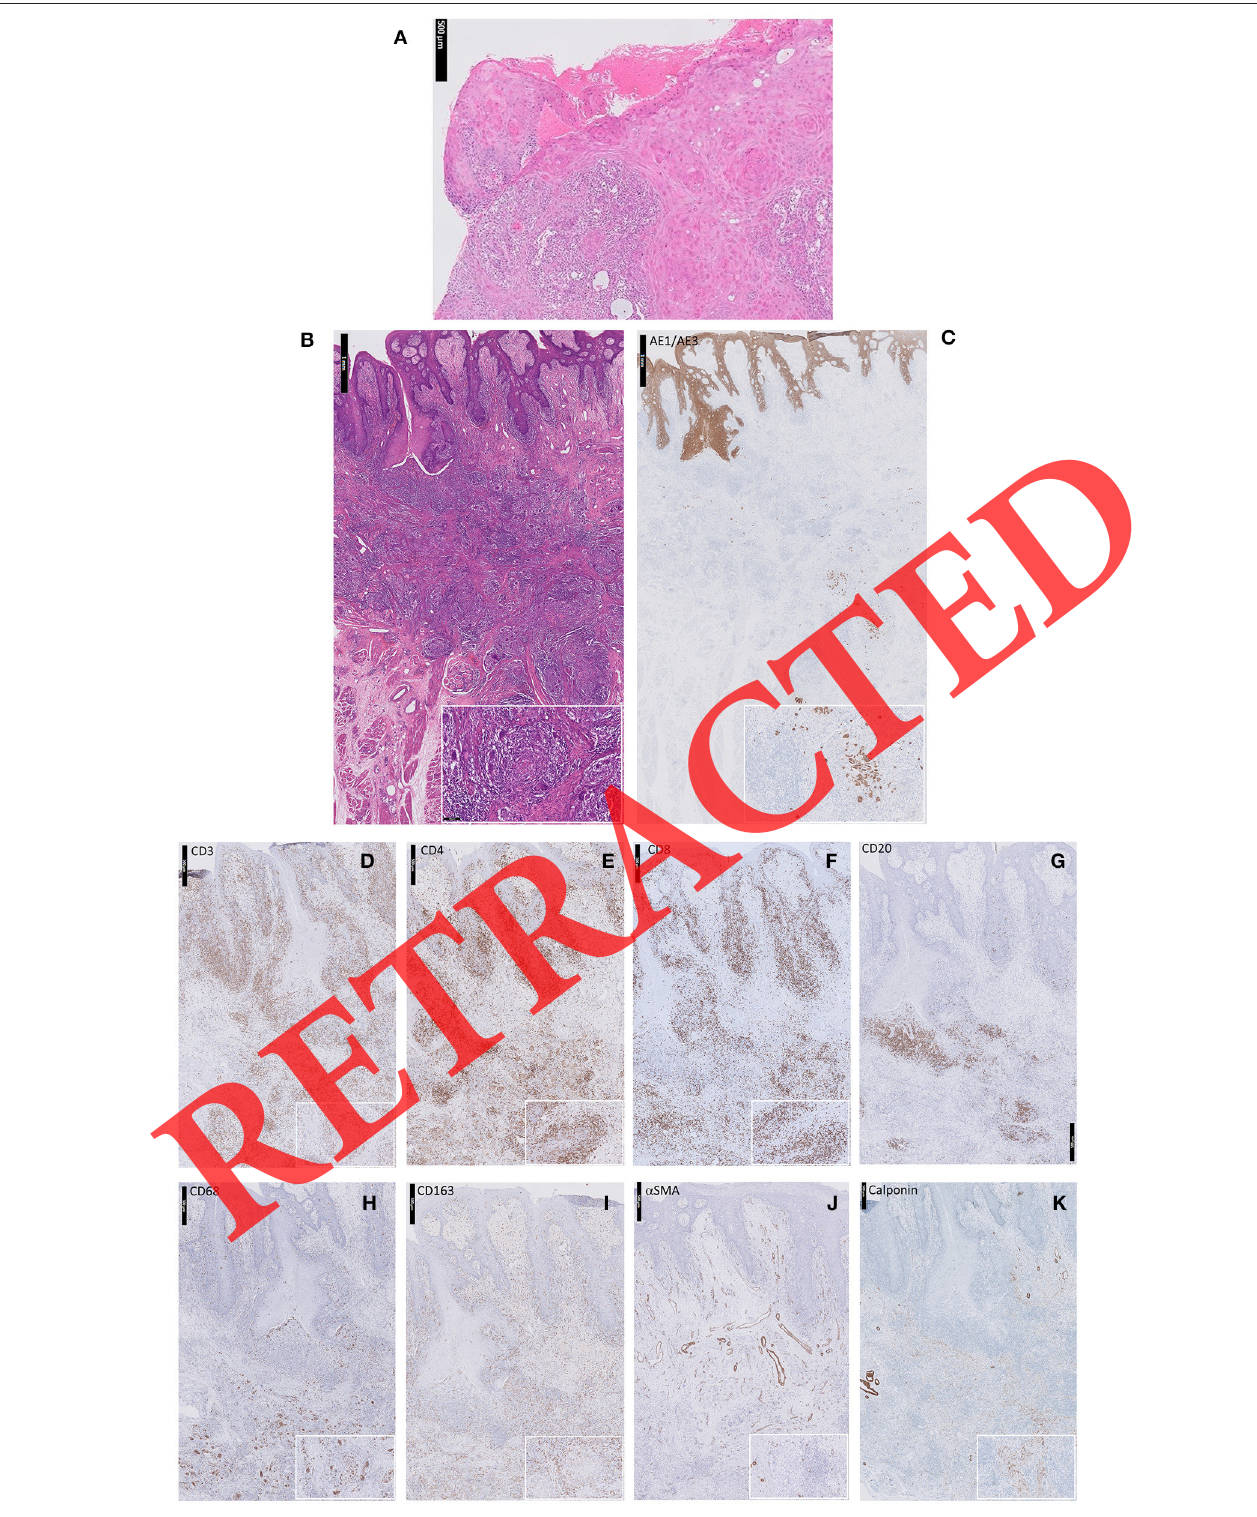
FIGURE 1 | Patient #1: Photomicrograph of the incisional biopsy, hematoxylin and eosin stain (A) ; Photomicrographs from the resection specimen, hematoxylin and eosin stain (B) , and immunohistochemically stained sections: pan-cytokeratin (AE1/AE3) (C) , CD3 (D) , CD4 (E) , CD8 (F) , CD20 (G) , CD68 (H) , CD163 (I) , alpha smooth muscle actin ( α SMA) (J) , calponin (K) ( A : scale bar 500 µ m, B,C : scale bar 1mm, and D–K: scale bar 500 µ m).